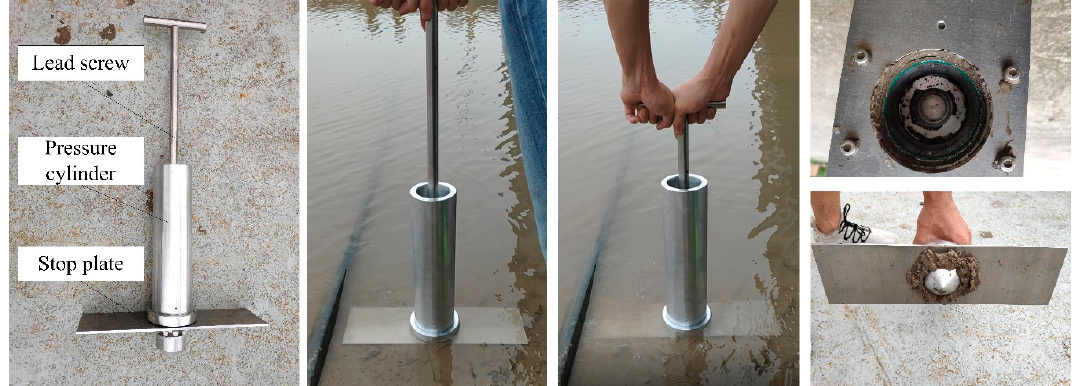
Figure 9. Sampling process of sampling cylinder.